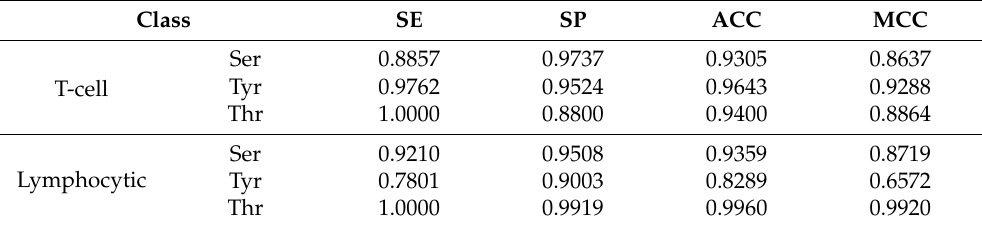
Table 3. Prediction results of transfer-learning applied to T-cell leukemia data and Lymphocytic leukemia data. Validation of some data sets using the leave-one-out (Loo) method due to the volume of